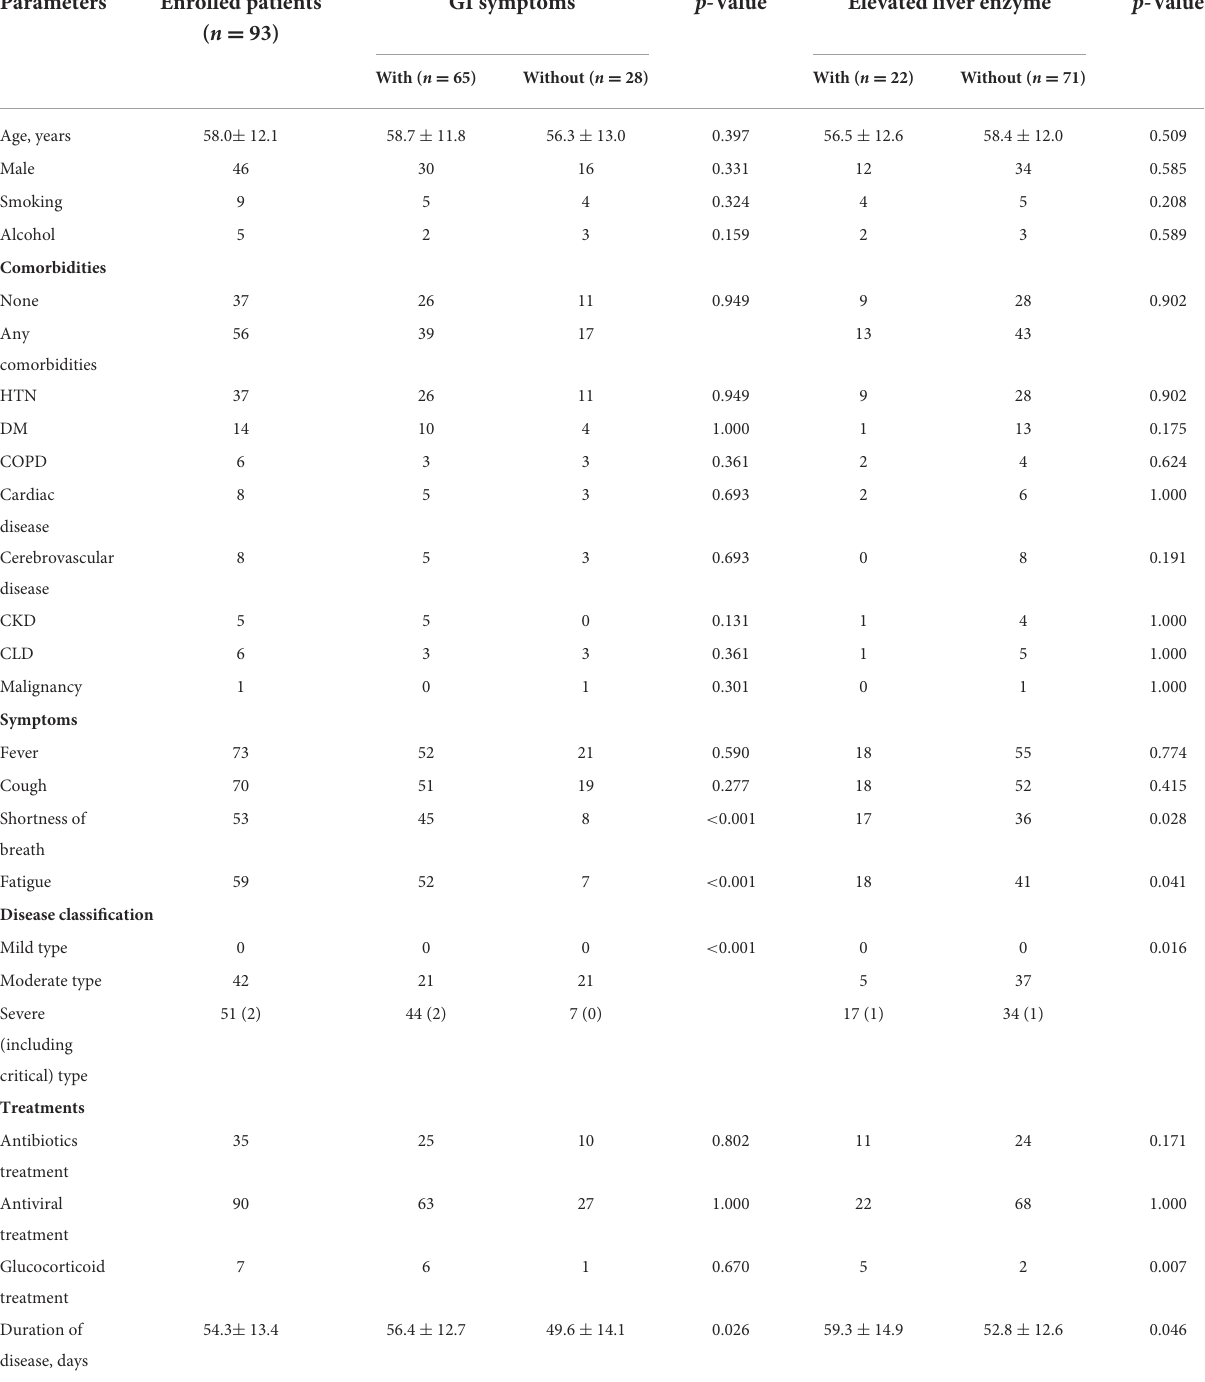
TABLE 1 Demographic and clinical parameters in patients with and without GI symptoms or elevated liver enzyme.